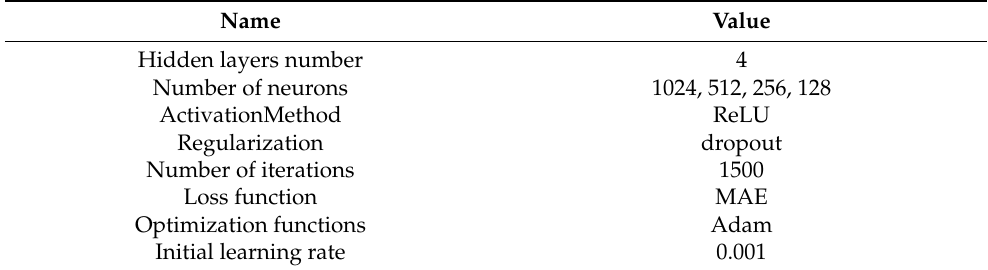
Table 4. Parameters of the DNN model. Name Value Hidden layers number 4 Number of neurons 1024, 512, 256, 128 ActivationMethod ReLU Regularization dropout Number of iterations 1500 Loss function MAE Optimization functions Adam Initial learning rate 0.001